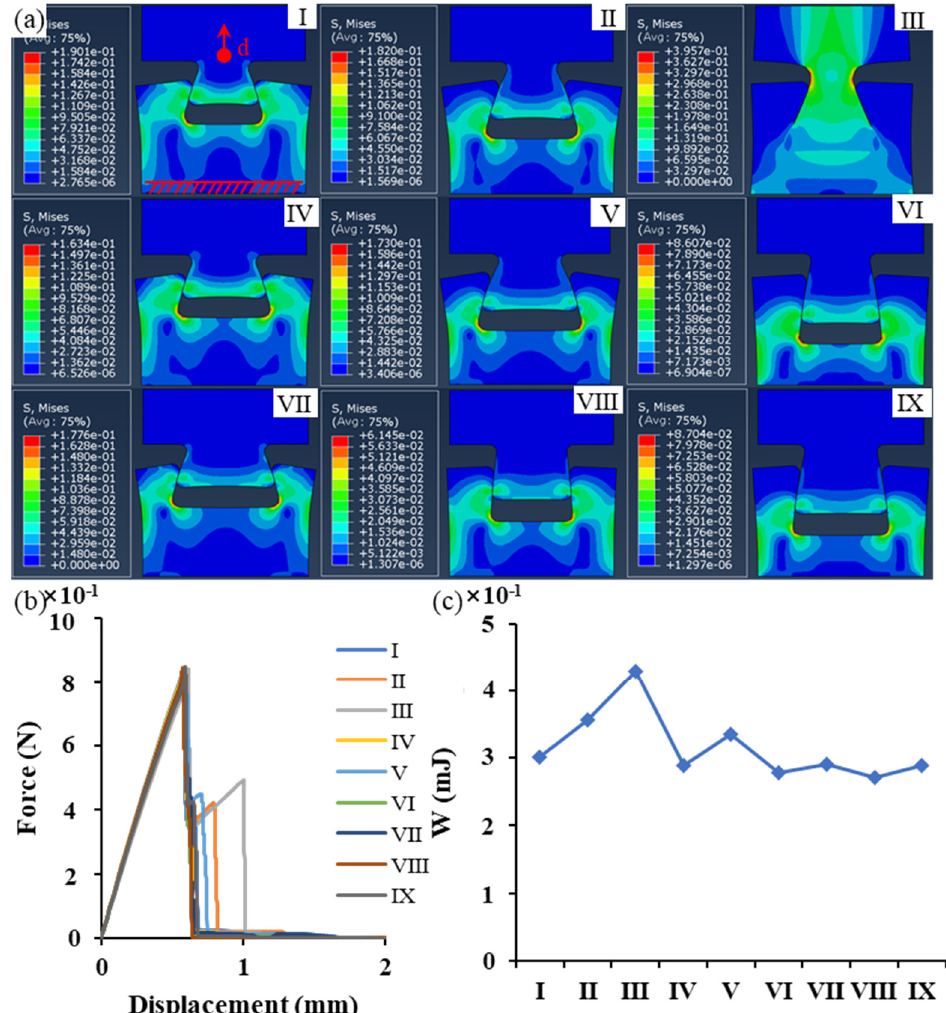
Figure 3. Finite element analysis and corresponding results for plane models of nine DTM parting structures: ( a ) finite element analysis of plane models for different DTM parting structures under the same displacement (0.6 mm); ( b ) interfacial separation force of nine DTM parting structures generated during interface separation; and ( c ) avulsion energy of nine DTM parting structures generated during interface separation.